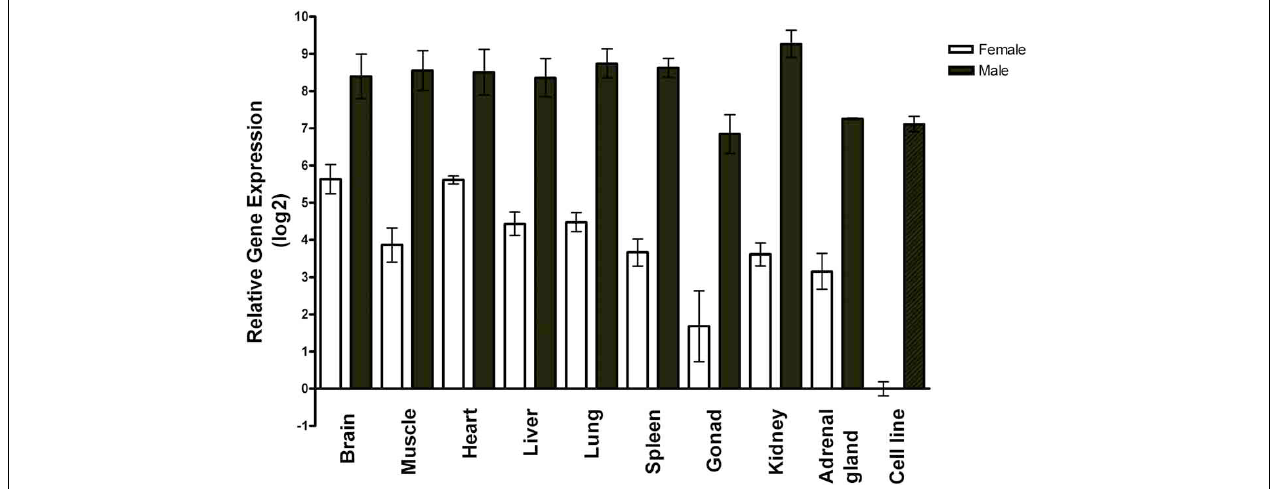
FIGURE 1 | Expression profile of miR-2954 in nine major tissues and two cell lines of zebra finch. Each bar represents the mean and standard error of expression measured by RT-qPCR, shown as the log2 of the fold-difference relative to the female cell line. Thus, the value for